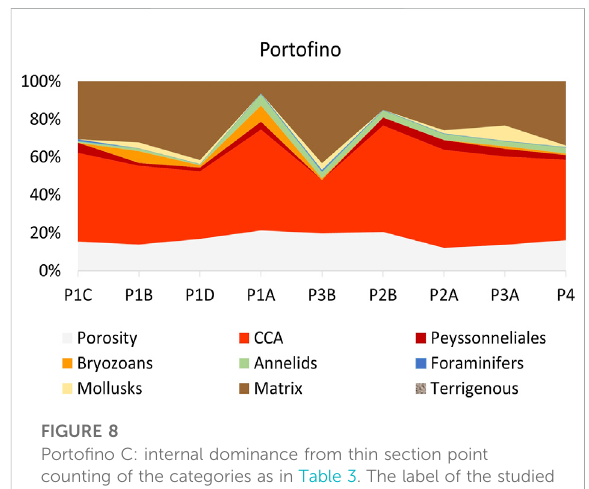
FIGURE 8 Porto fi no C: internal dominance from thin section point counting of the categories as in Table 3. The label of the studied thin sections is reported on the horizontal axis.